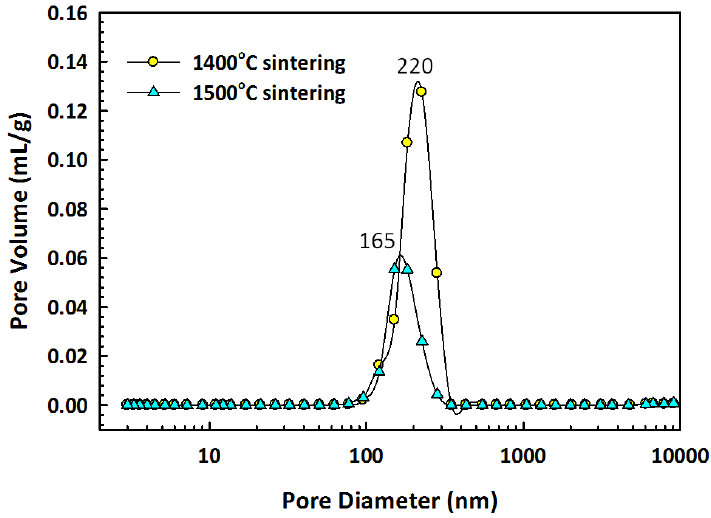
Figure 3. Pore size distribution, as measured by a mercury porosimeter.